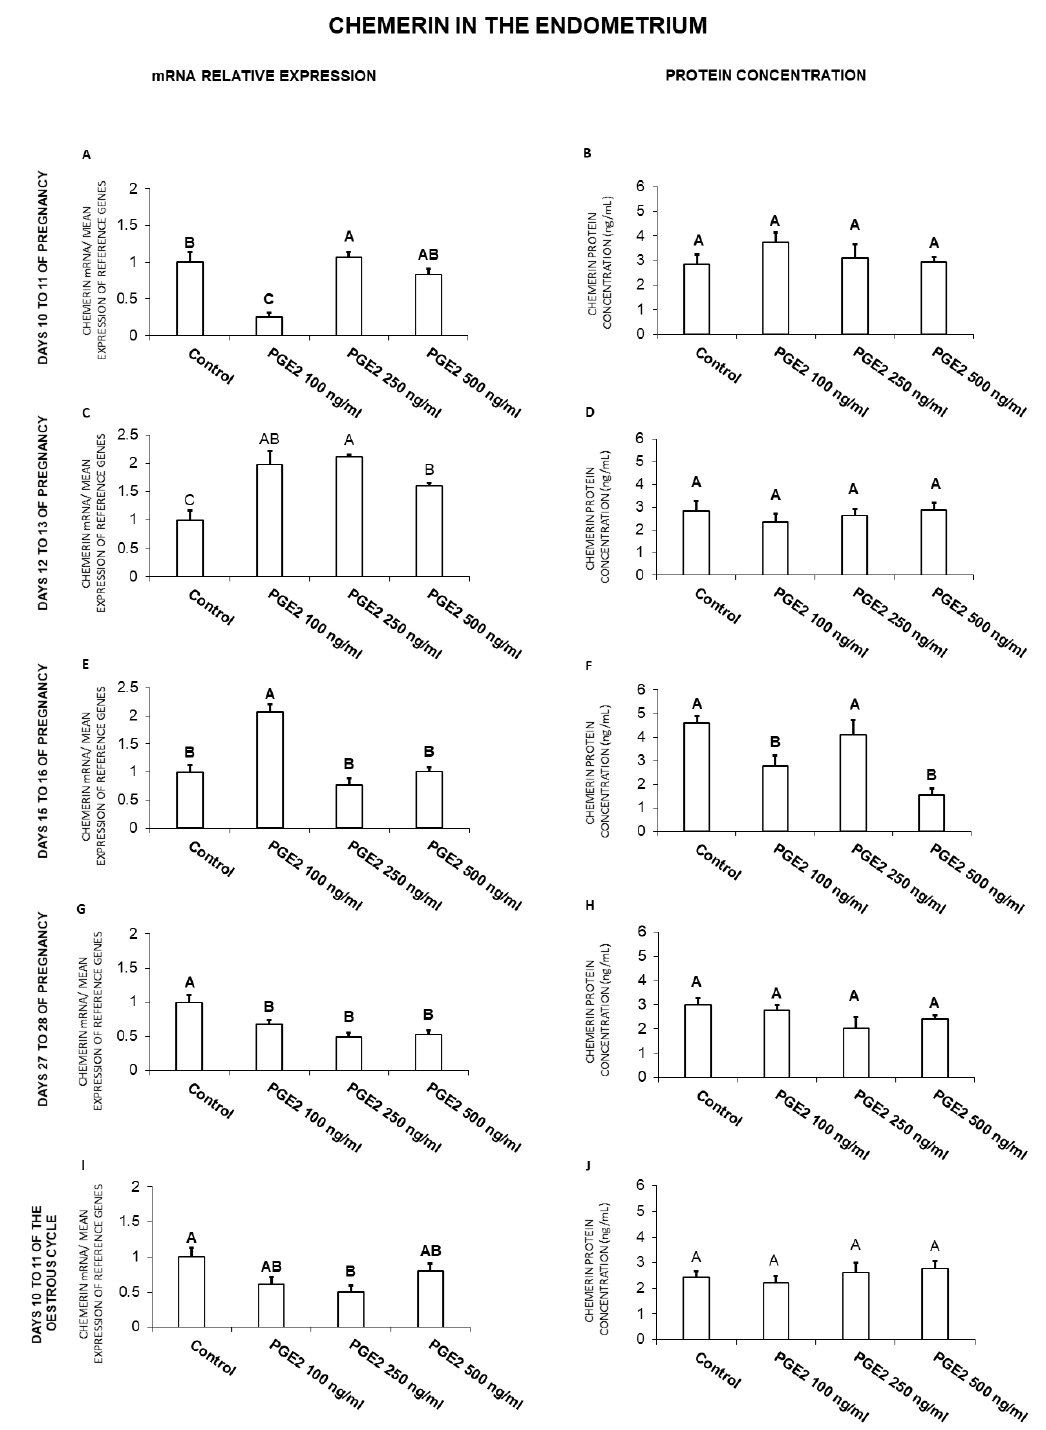
Figure 1. The influence of prostaglandin E 2 (PGE 2 ; 100, 250, 500 ng / mL) on chemerin mRNA expression ( A , C , E , G , I ) and chemerin protein secretion ( B , D , F , H , J ) in the porcine endometrial tissue explants on days 10 to 11, 12 to 13, 15 to 16 and 27 to 28 of the pregnancy, and on days 10 to 11 of the estrous cycle. The gene expression was determined by quantitative real-time PCR. The protein secretion was determined by an ELISA test. Results are reported as the means ± S.E.M. ( n = 5). Bars with different superscripts differ ( p < 0.05).